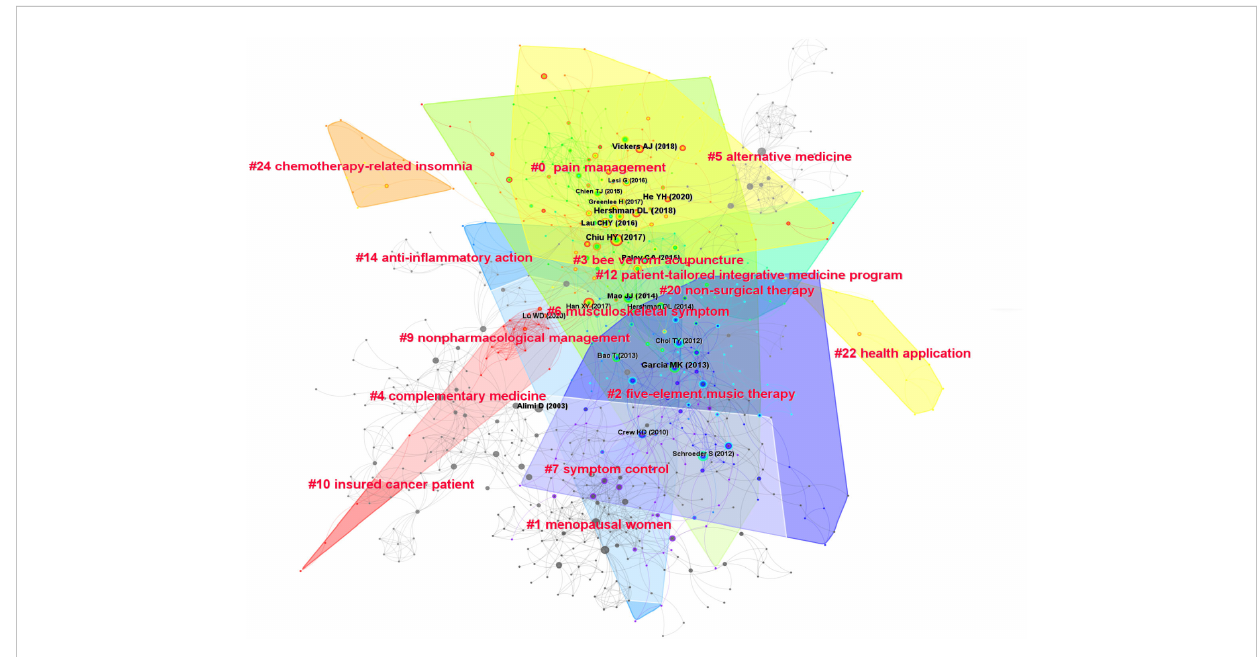
FIGURE 7 Cited references map related to the research of acupuncture for cancer pain.